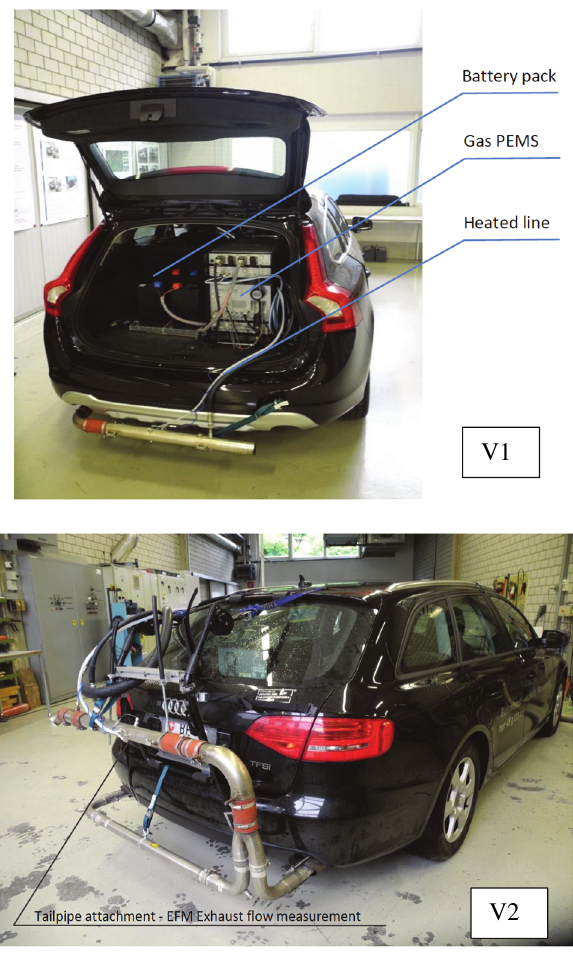
Fig. 3. Tested vehicles (FFV) equipped with PEMS